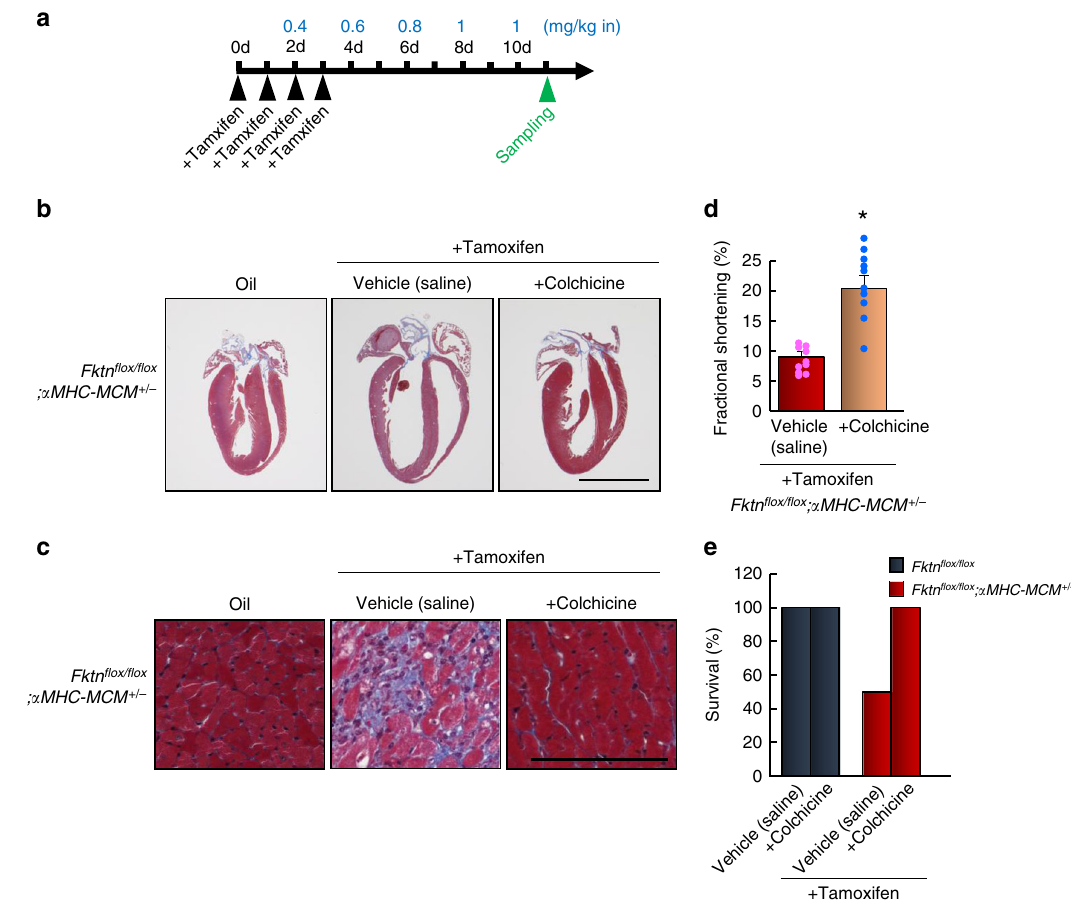
Fig. 9 The effects of MT depolymerization in α MHC-MCM- Fktn -cKO ( Fktn fl ox/ fl ox ; α MHC-MCM + / − ) hearts. a Schedule of tamoxifen administration, colchicine treatment, and sample collection. Blue letters show the dose of colchicine. b Cardiac morphology (scale bar, 5 mm). c Masson ’ s trichrome staining of the left ventricle (scale bar, 50 μ m). Cardiac function in tamoxifen-treated α MHC-MCM- Fktn -cKO hearts treated with colchicine ( d ) and survival percentages ( e ) ( n = 10 per group). * P < 0.05 vs. tamoxifen-treated α MHC-MCM- Fktn -cKO mice based on Student ’ s t